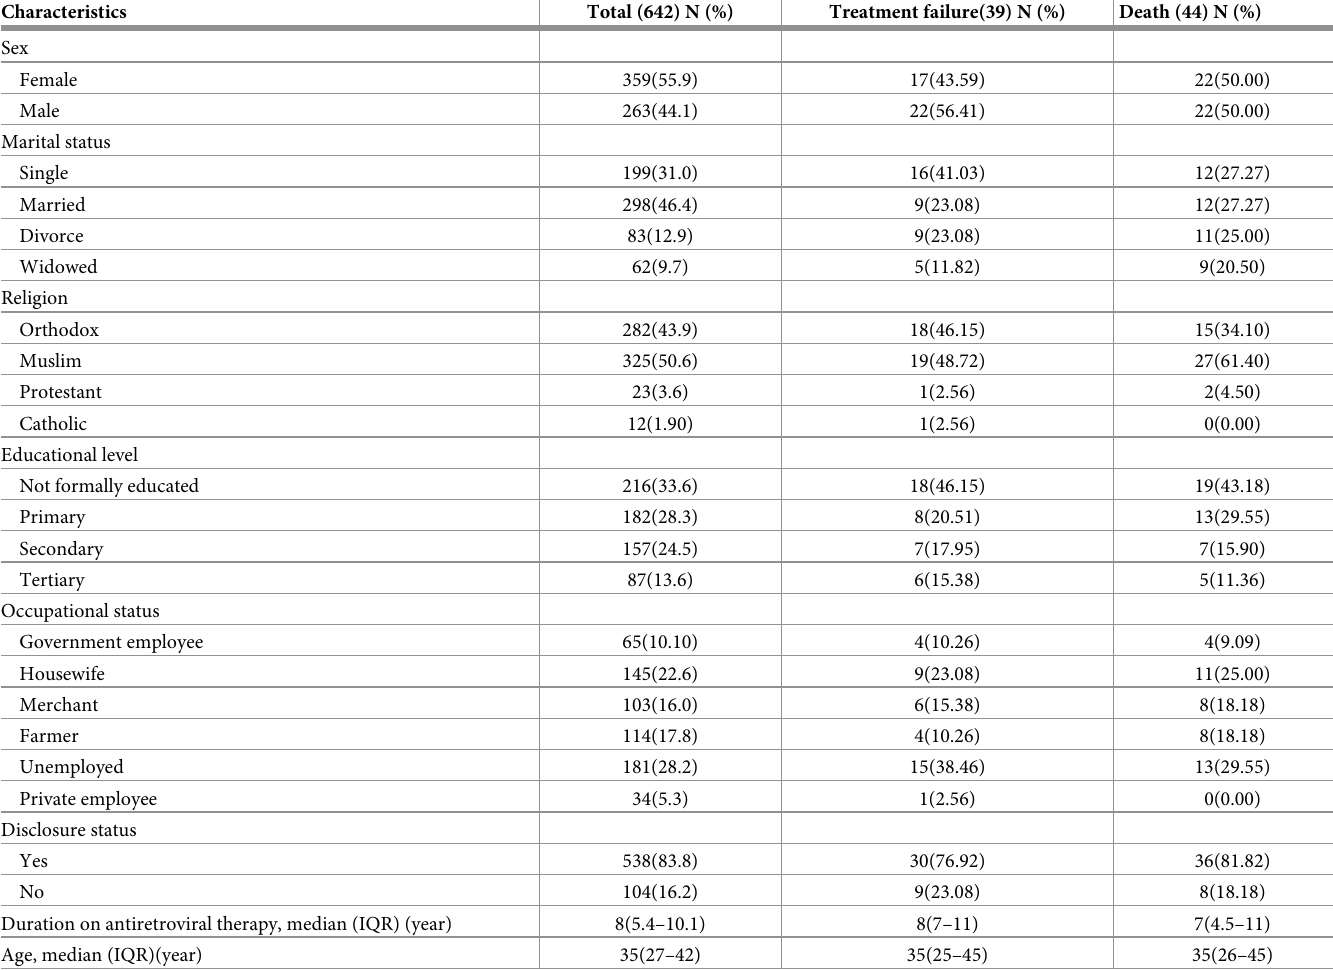
Table 1. Socio-demographic characteristics of PLWHIV on second-line antiretroviral therapy at Dessie Comprehensive Specialized Hospital, northeast Ethiopia, October 2016—November 2019. (n = 642).